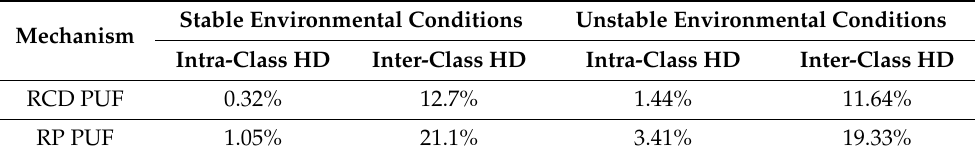
Table 3. Inter-class (HD) and intra-class HD, considering environmental conditions. Mechanism